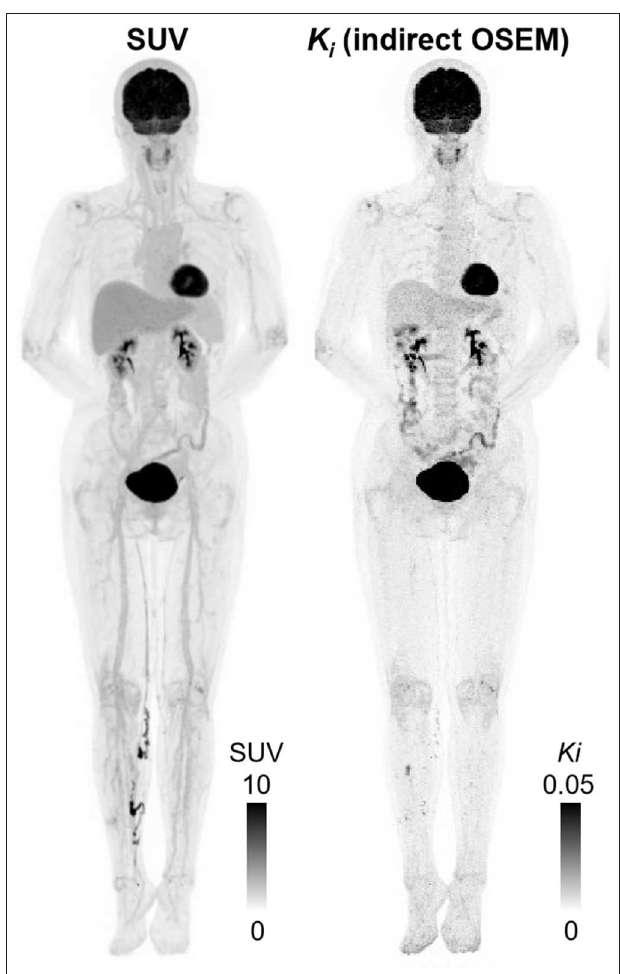
FIGURE 2 | Maximum intensity projection (MIP) using last 30min of data (left to right): SUV; indirect OSEM Patlak slope K i (3 iterations 10 subsets); This research was originally published in JNM [ 9].